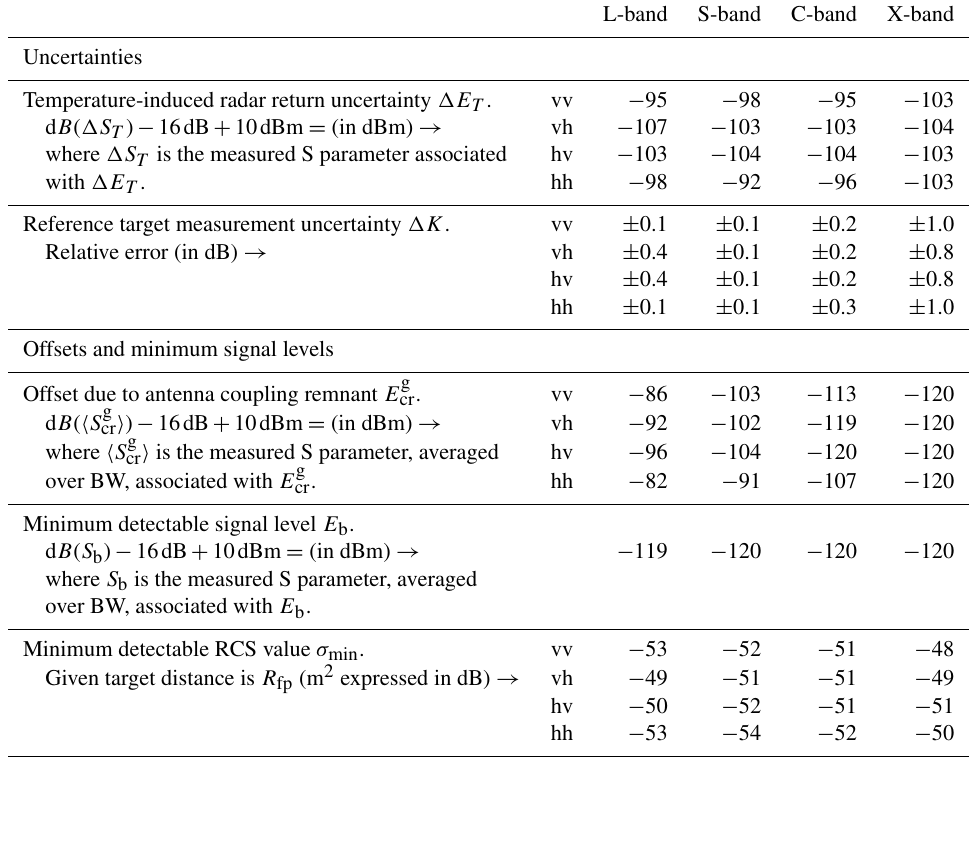
g cr , and E b , table values are the